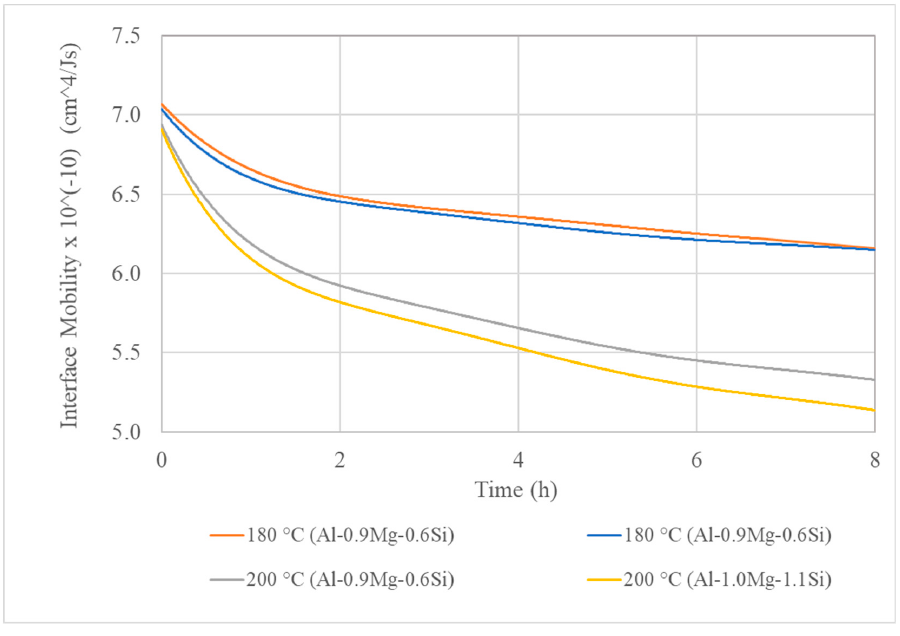
Figure 14. Temporal evolution of interface mobility. Table 6. Diffusion coefficients of Mg and Si in the matrix phase.